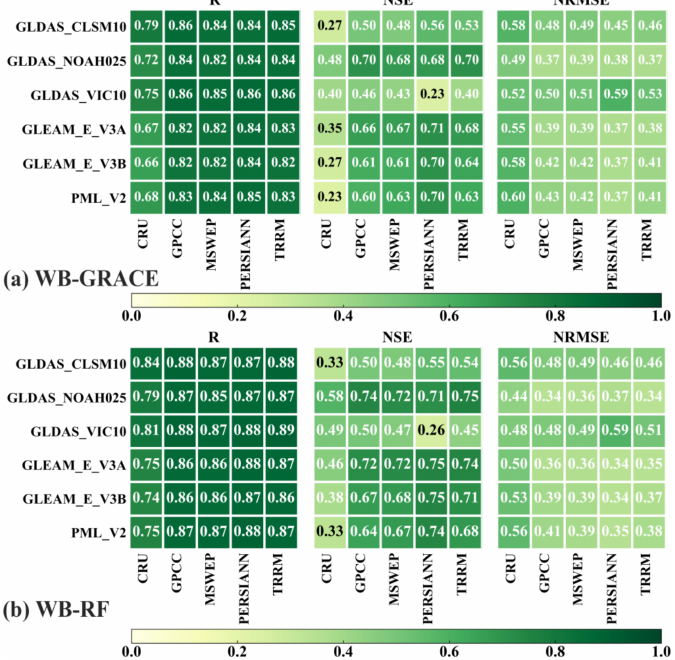
Figure 12. The quantitative performance of the multi-source precipitation and ET products on the es- timated discharge. ( a , b ) refer to the estimated discharge using WB-GRACE and WB-RF,